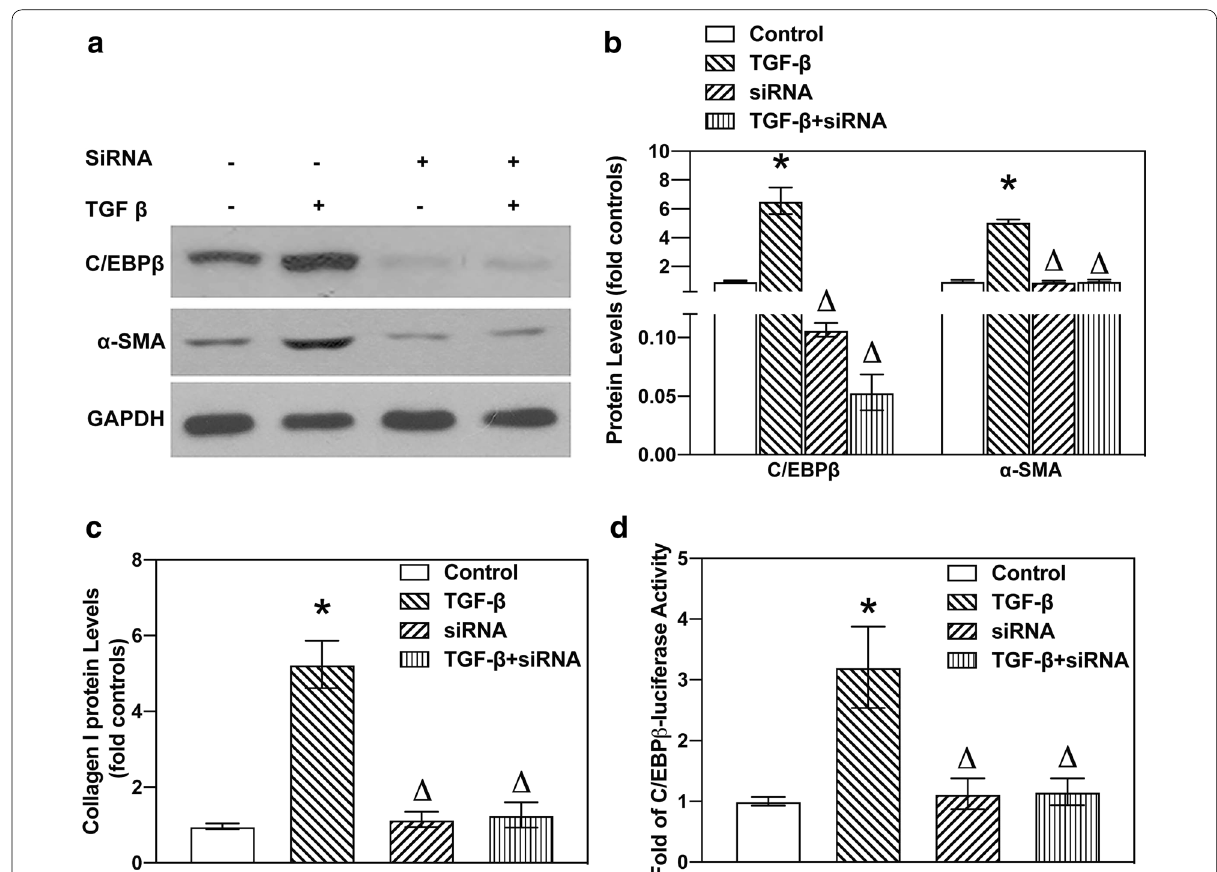
Fig. 3 TGF-β up-regulated the expression of α-SMA via C/EBPβ activation in A549 cells. a TGF-β increased α-SMA protein levels via C/EBPβ activation. A549 cells were treated with TGF-β (10 ng/mL) for 24 h with or without the presence of C/EBPβ siRNA (10 nM) for 8 h. Levels of C/EBPβ and α-SMA in cell lysate were analysed using western blotting. b Quantification of western blots were calculated according to grey analysis. c The C/ EBPβ siRNA blocked TGF-β-induced increase in collagen-I synthesis. The effect of C/EBPβ siRNA on collagen-I deposition in TGF-β-treated A549 cells was analysed using ELISA. d TGF-β-induced C/EBPβ-luciferase activity is regulated by the C/EBPβ siRNA. A549 cells transfected with C/EBPβ siRNA successfully attenuated TGF-β-activated C/EBPβ-luciferase activity. Asterisk (*) denotes significant difference (P <